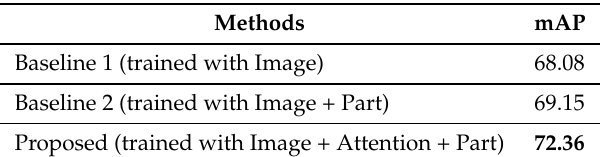
Table 6. Comparison of mAP with the baseline methods on the V-COCO Dataset [16]. Bold font indicates the best result.